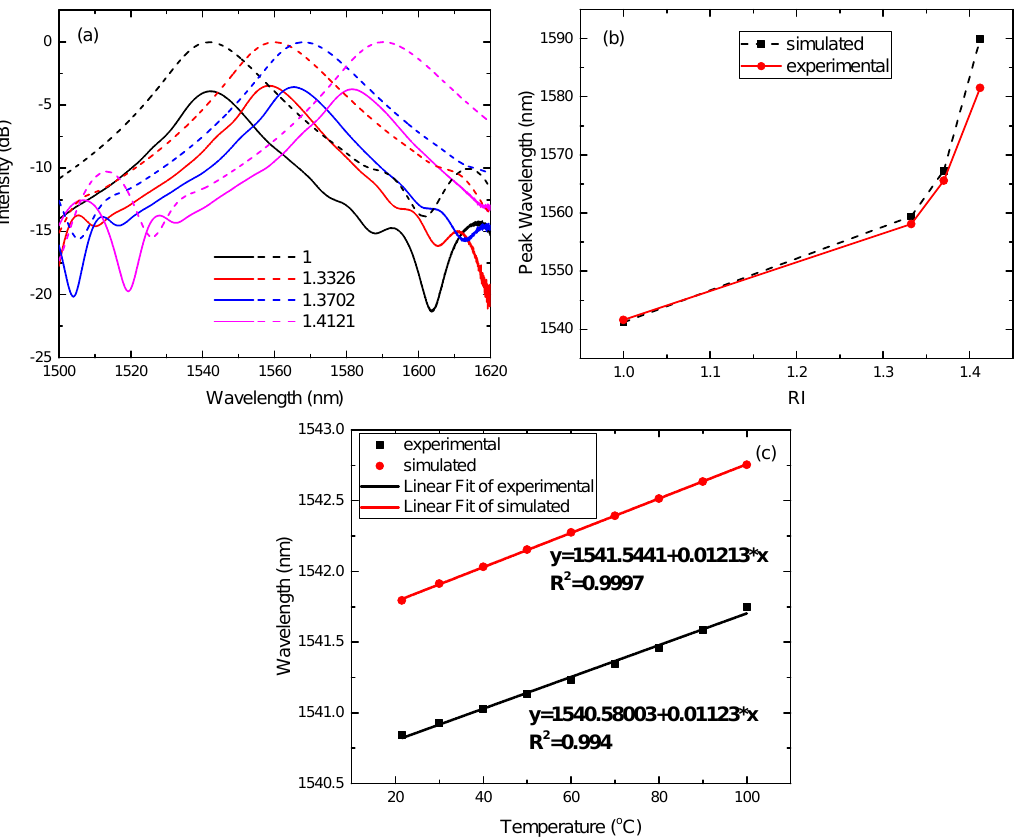
Figure 6. a NCF = 40 µ m and z NCF = 24mm. ( a ) The transmission spectra of the SNCS structure; ( b ) the response between the peak wavelength and cladding RI; ( c ) the response between the peak wavelength and temperature and the linear